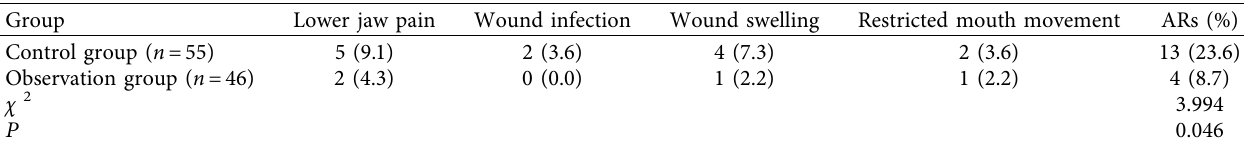
Table 4: Comparison of